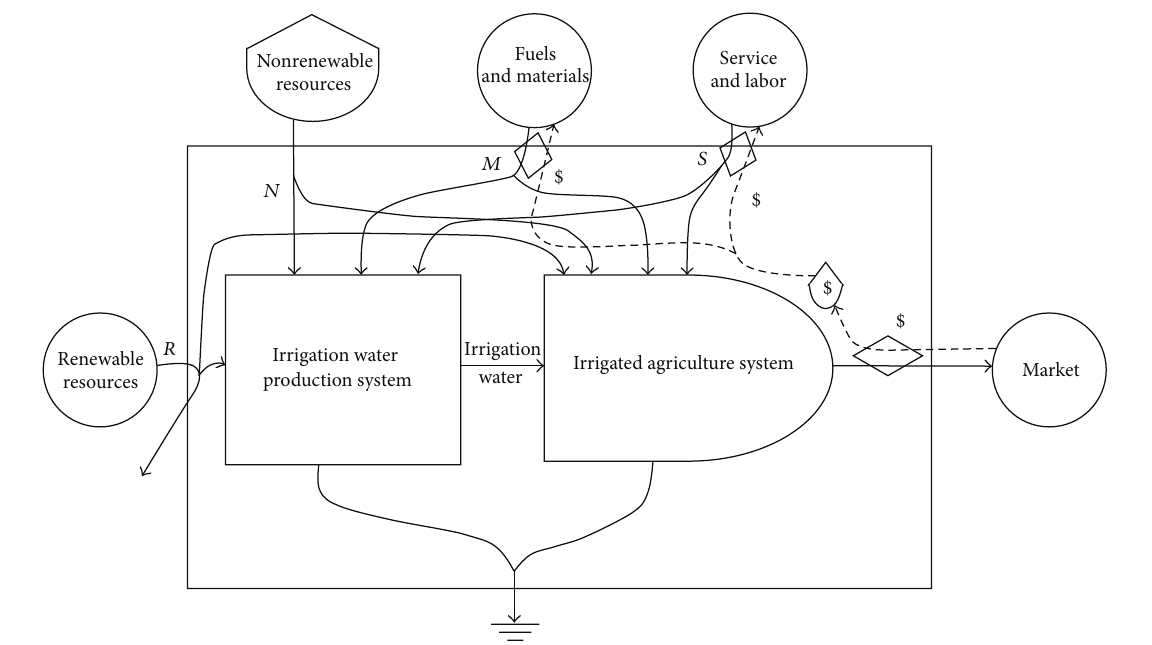
Figure 4: Energy systems diagram of the integrated production system of irrigation water and irrigated agriculture.